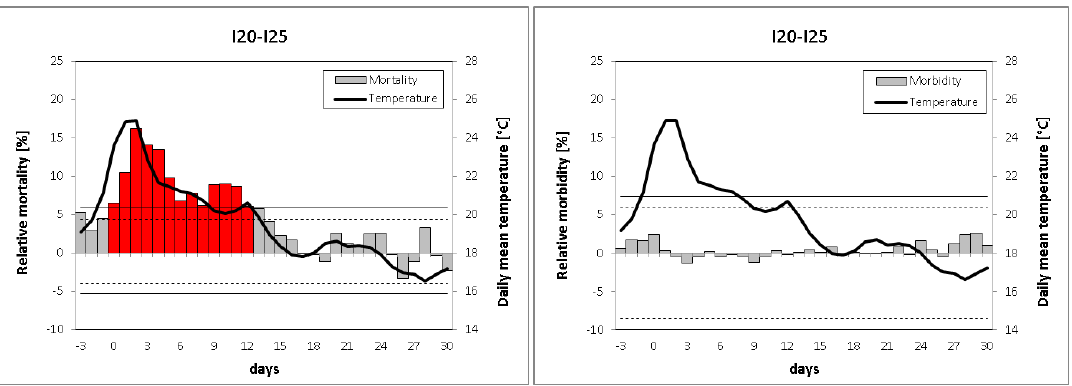
Figure 2. Mean relative deviations of IHD mortality ( left ) and morbidity ( right ) for 34-day sequences of heat waves beginning from three days before up to 30 days after the onset of the heat waves. Solid (dashed) lines denote the 99% (95%) confidence interval obtained by the Monte Carlo method, highly significant relative deviations (α < 0.01) are colored in red.